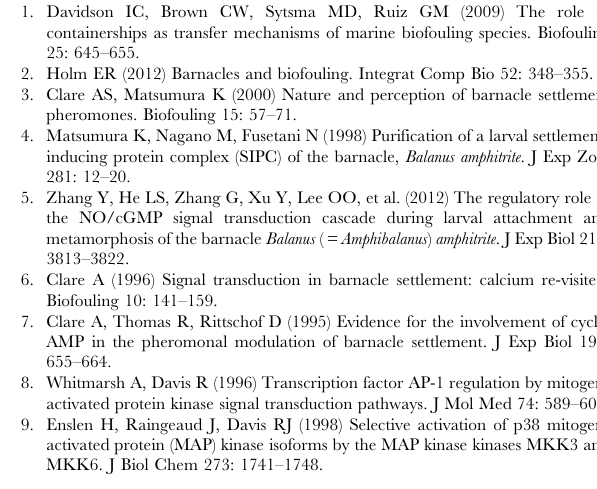
Figure S1 The alignments of MKKs and MAPKs in Amphibalanus amphitrite . The full-length coding regions of MKKs and MAPKs were aligned using the ClustalW2 tool. The dual phosphorylation sites of these genes were labeled with asterisks and the subdomains I to XI were indicated with Roman numbers. (A). The alignment of three MKK genes. The N-termini are different among the three MKK genes, which is highlighted in the blue box. (B) Alignment of JNK, ERK and p38MAPK. The activation loops of the three MAPK genes are labeled with a red box. (TIF) Table S1 The fly genes from Drosophila and human used to identify MAKPs and MKKs in the Amphibalanus amphitrite transcriptome database. (TIF) Table S2 The contig numbers of MAPK and MKK genes in the Amphibalanus amphitrite transcriptome database and Genbank access numbers for the complete coding regions of these genes. By blasting against the A. amphitrite transcriptome database using human or Drosophila genes, several MKK and MAPK homologs were identified in A. amphitrite . After RACE reactions, the complete coding regions of these genes were identified and deposited into Genbank. (TIF) Table S3 Primers used in this study. (TIF) Movie S1 Z-stack results of the inmmunostaining area for pMKK3. Cyprids stained for pMKK3 in Figure 5 were further examined at the highest magnification with a 63X objective. The Z-stack images were taken at an interval of 0.2 m m for a total height of 34 m m.